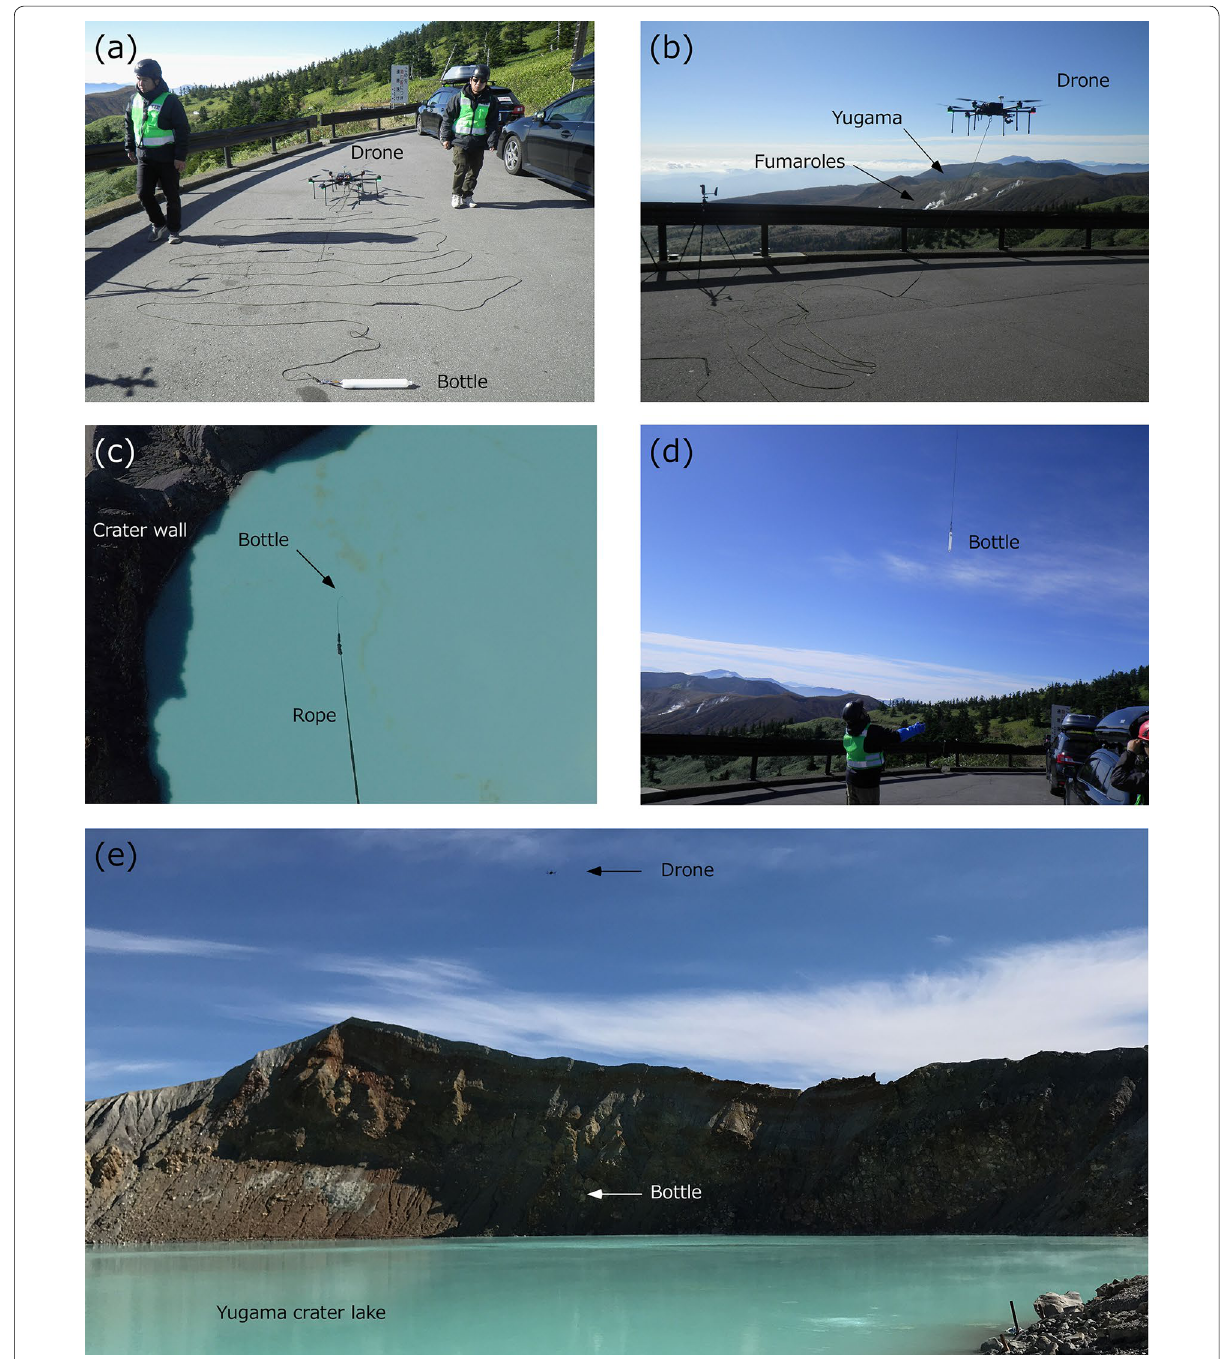
Fig. 2 Photographs of the drone operation on October 18, 2017. a Setup of the drone LAB645, with the rope and sampling bottle on the ground. b Taking off with the suspended sampling bottle. c Photograph above sampling point B shown in Fig. 1, taken by a camera on the drone. d Catching the bottle by hand just before landing. e Approach of the drone and sampling bottle to the surface of Yugama crater